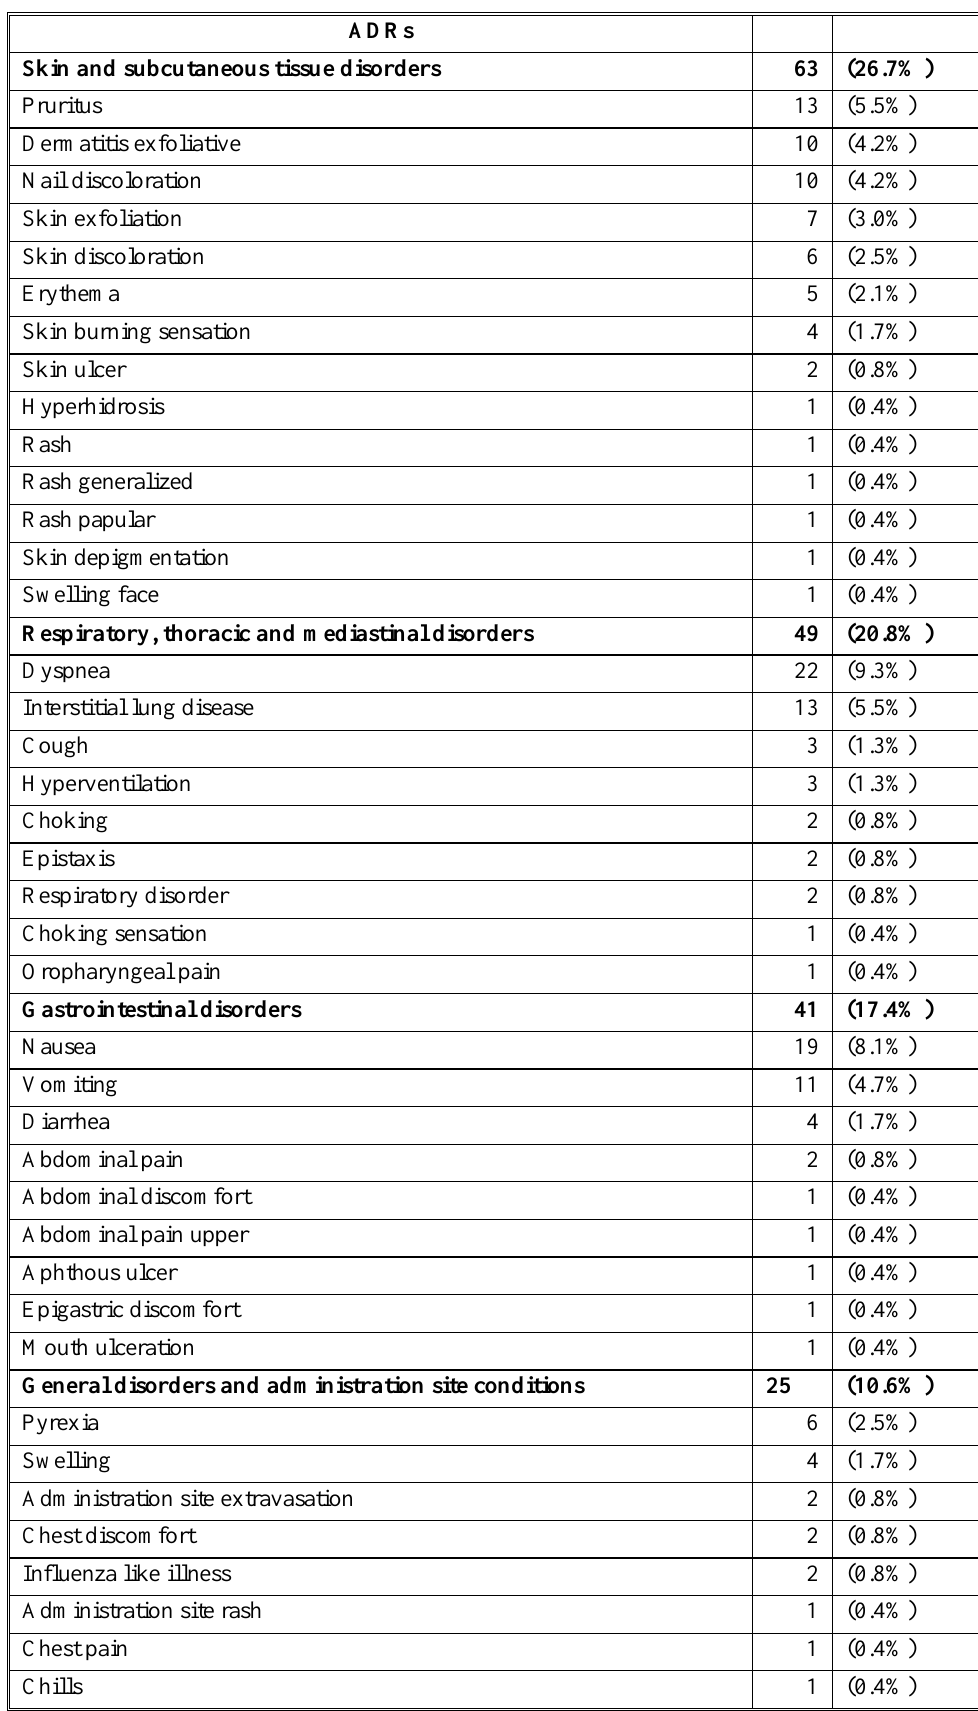
Table 6. ADRs in preferred term grouped by system organ classification for docetaxel